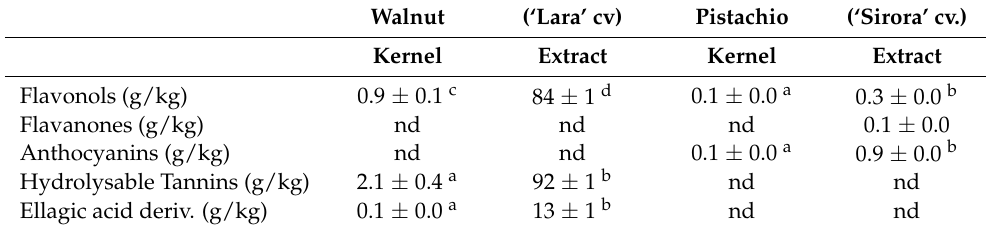
Walnut (‘Lara’ cv) Pistachio (‘Sirora’ cv.) Kernel Extract Kernel Extract